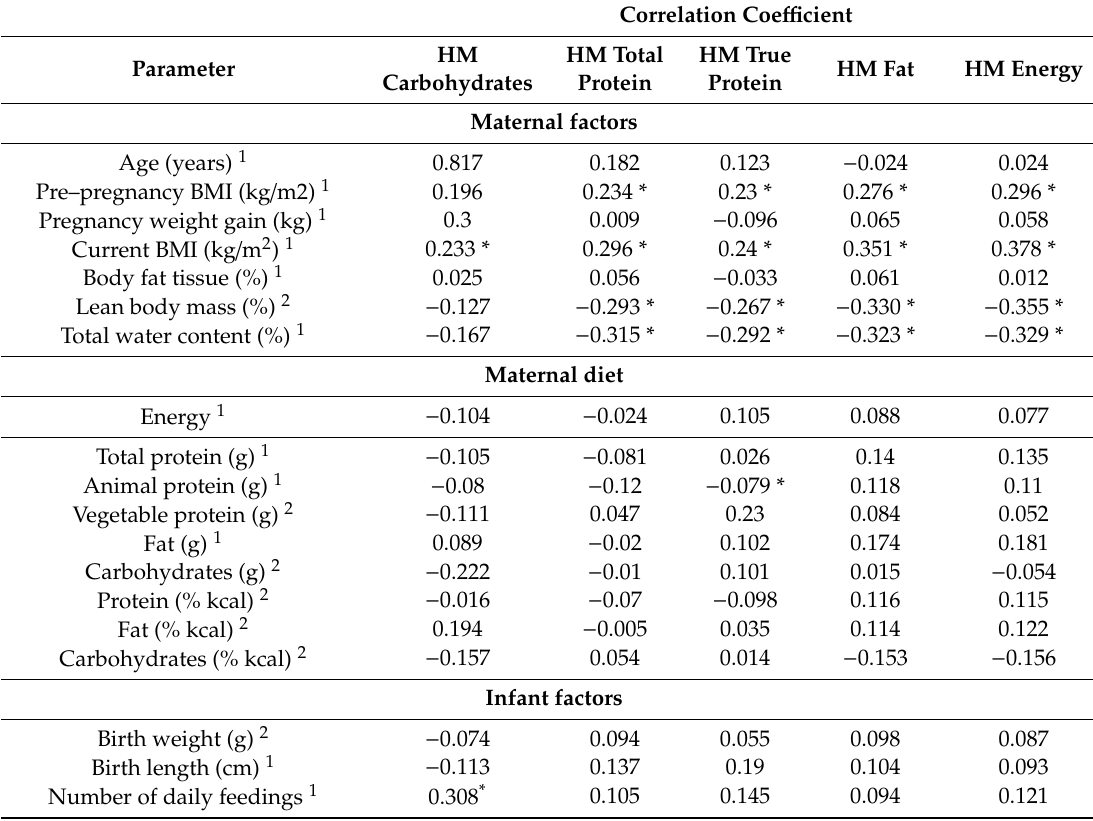
Table 4. Correlations between maternal factors, maternal diet, infant factors and HM